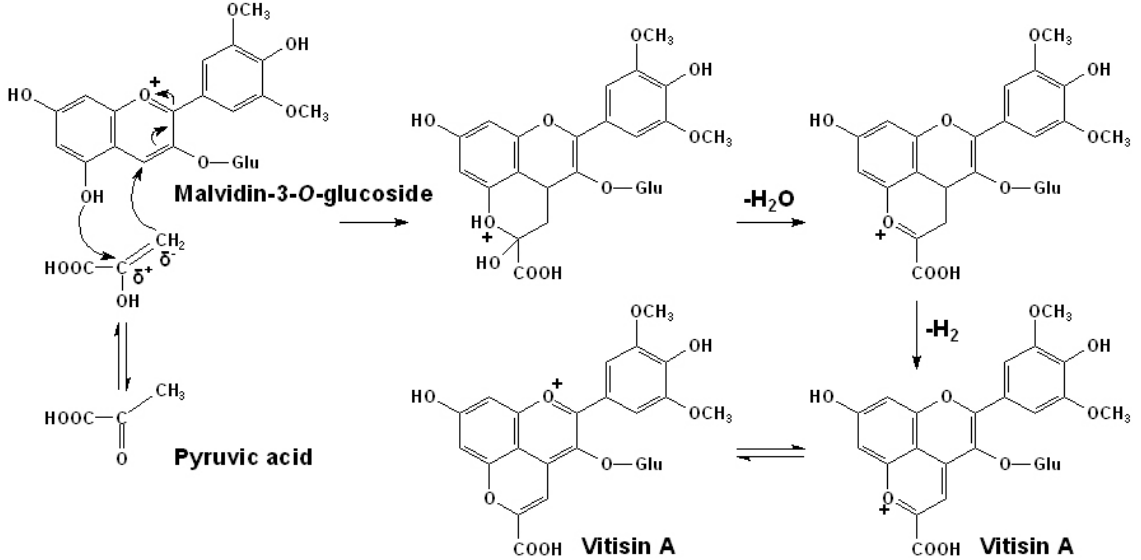
Scheme 1. Formation mechanism of vitisin A